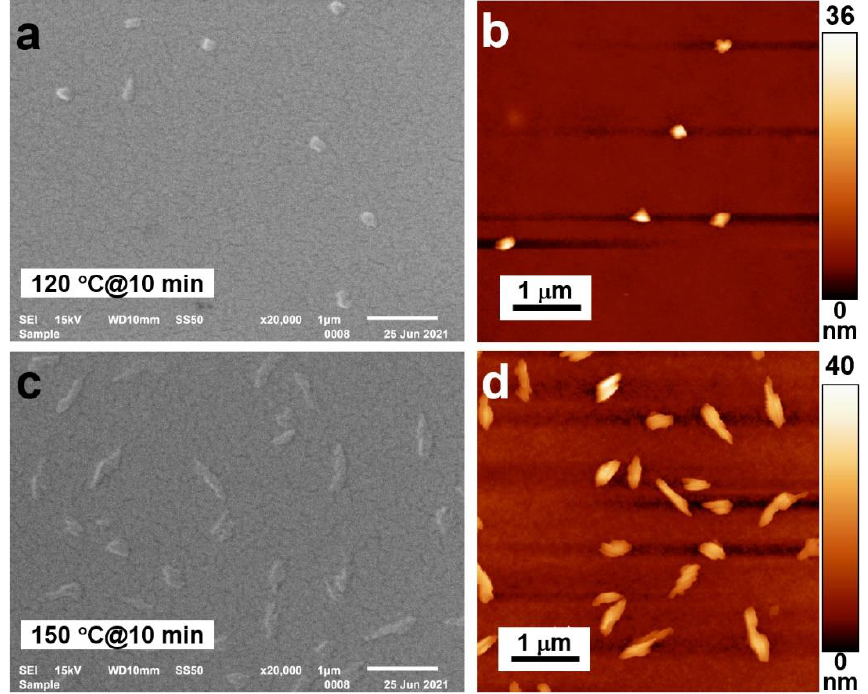
Figure 2. SEM (( a ) and ( c )) and AFM (( b ) and ( d )) images for the samples annealed at 120 (( a ) and Figure 2. SEM ( a , c ) and AFM ( b , d ) images for the samples annealed at 120 ( a , b ) and 150 ◦ C ( c , d ( b )) and 150 °C (( c ) and ( d )).